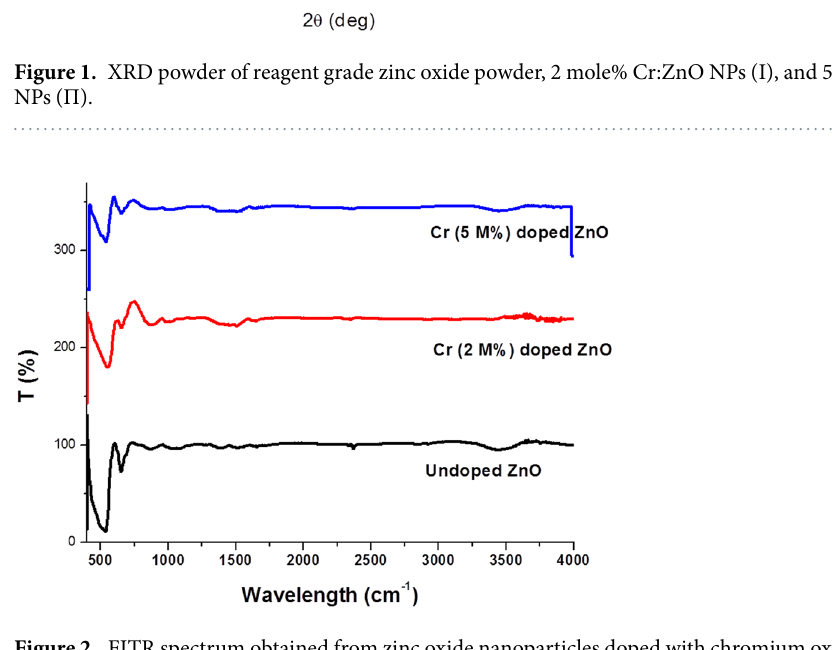
Figure 2. FITR spectrum obtained from zinc oxide nanoparticles doped with chromium oxide type